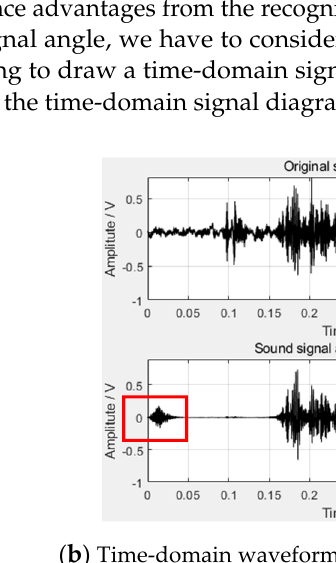
Figure 6. One sound signal filtered by Wiener filtering .